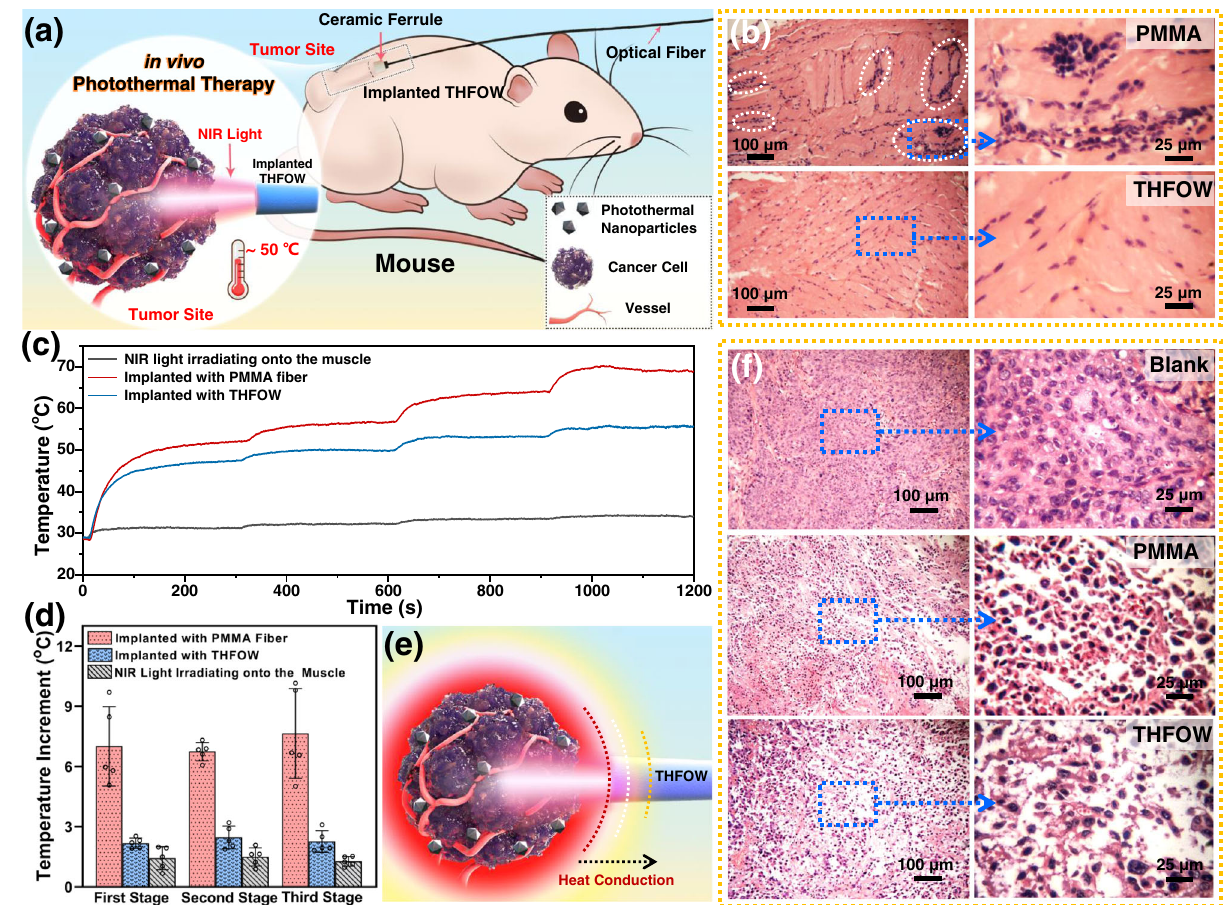
Fig.6|ControllablephotothermaltherapyappliedbytheTHFOW.a Schematic illustration of the controllable photothermal therapy in vivo; ( b ) H&E stained muscle slices harvested from the tissues of mice in contact with PMMA fi ber and THFOW; ( c ) Temperature changes of tumors/muscle monitored by the infrared thermal camera during laser irradiation; ( d ) Temperature increment during the